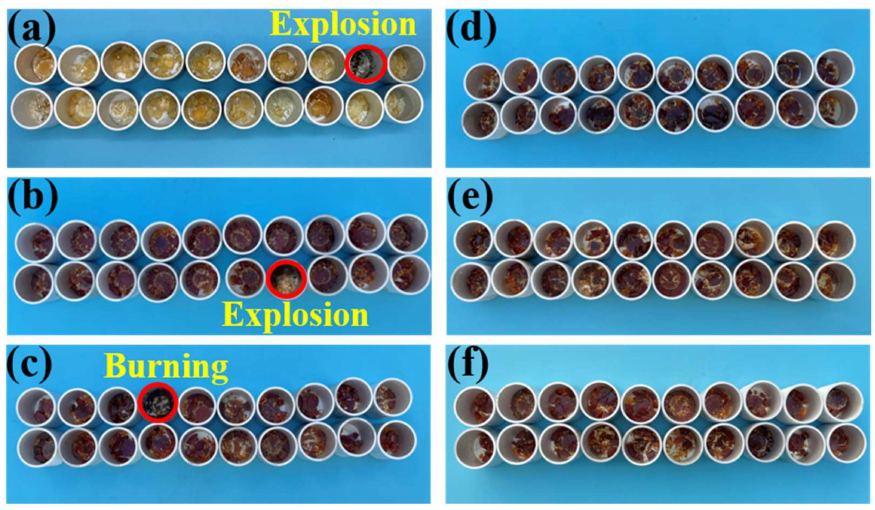
Figure 3. Schematic of ( a ) pure EP, ( b ) EP/BCI-25, ( c ) EP/BCI/BSEA-2, ( d ) EP/BCI/BSEA-3,